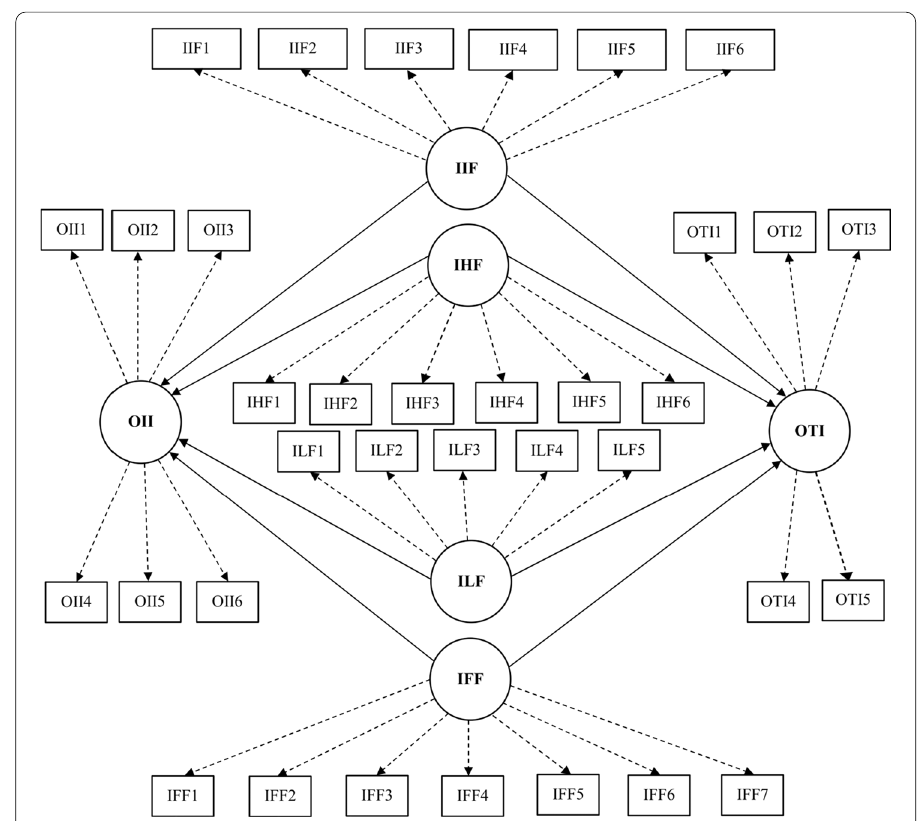
Fig. 1 Schematic diagram of internal and external relationships of the